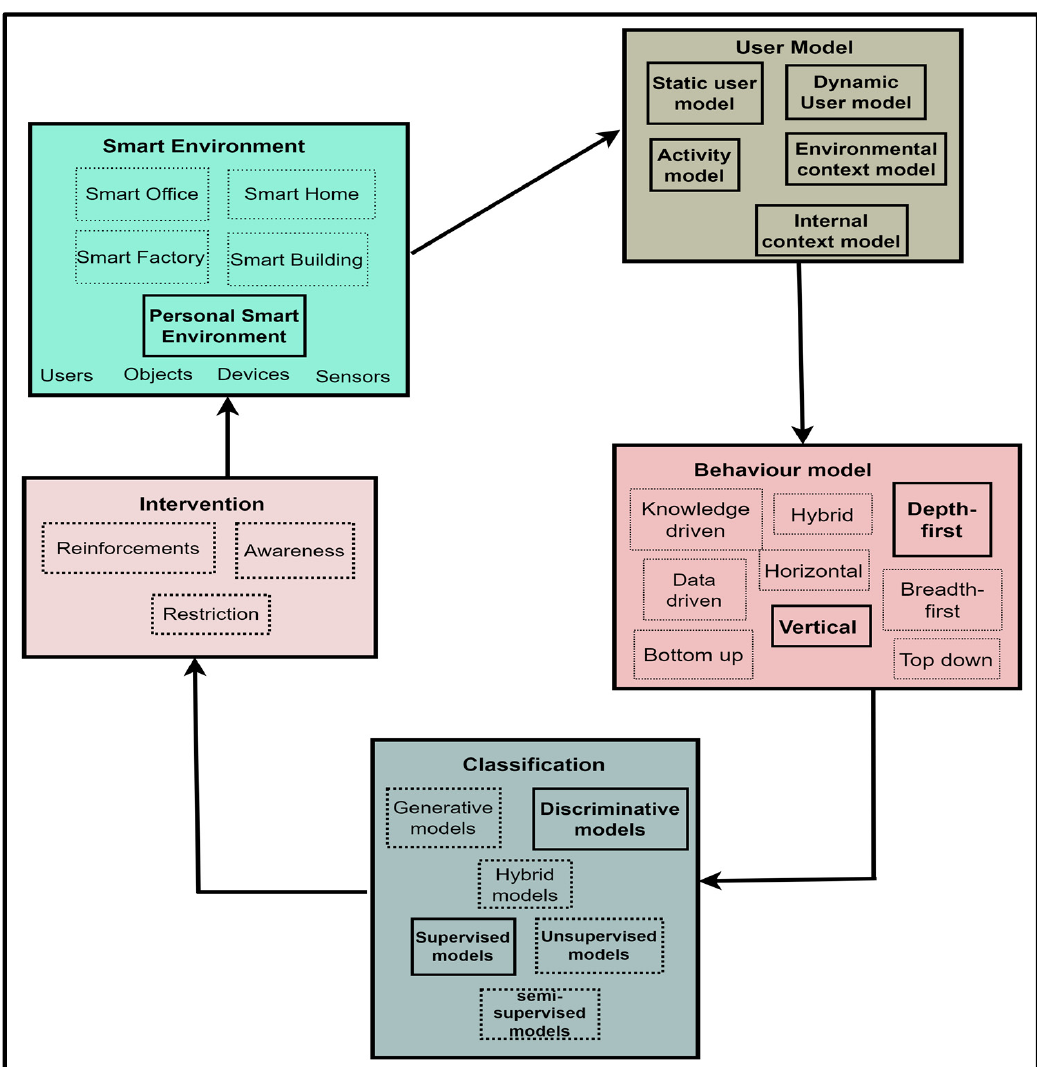
Figure 8. The Extended PBC Model.